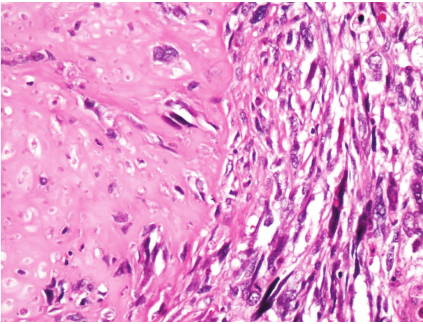
Figure 4: Interface of chondrosarcoma and rhabdomyosarcoma. H&E: × 200.